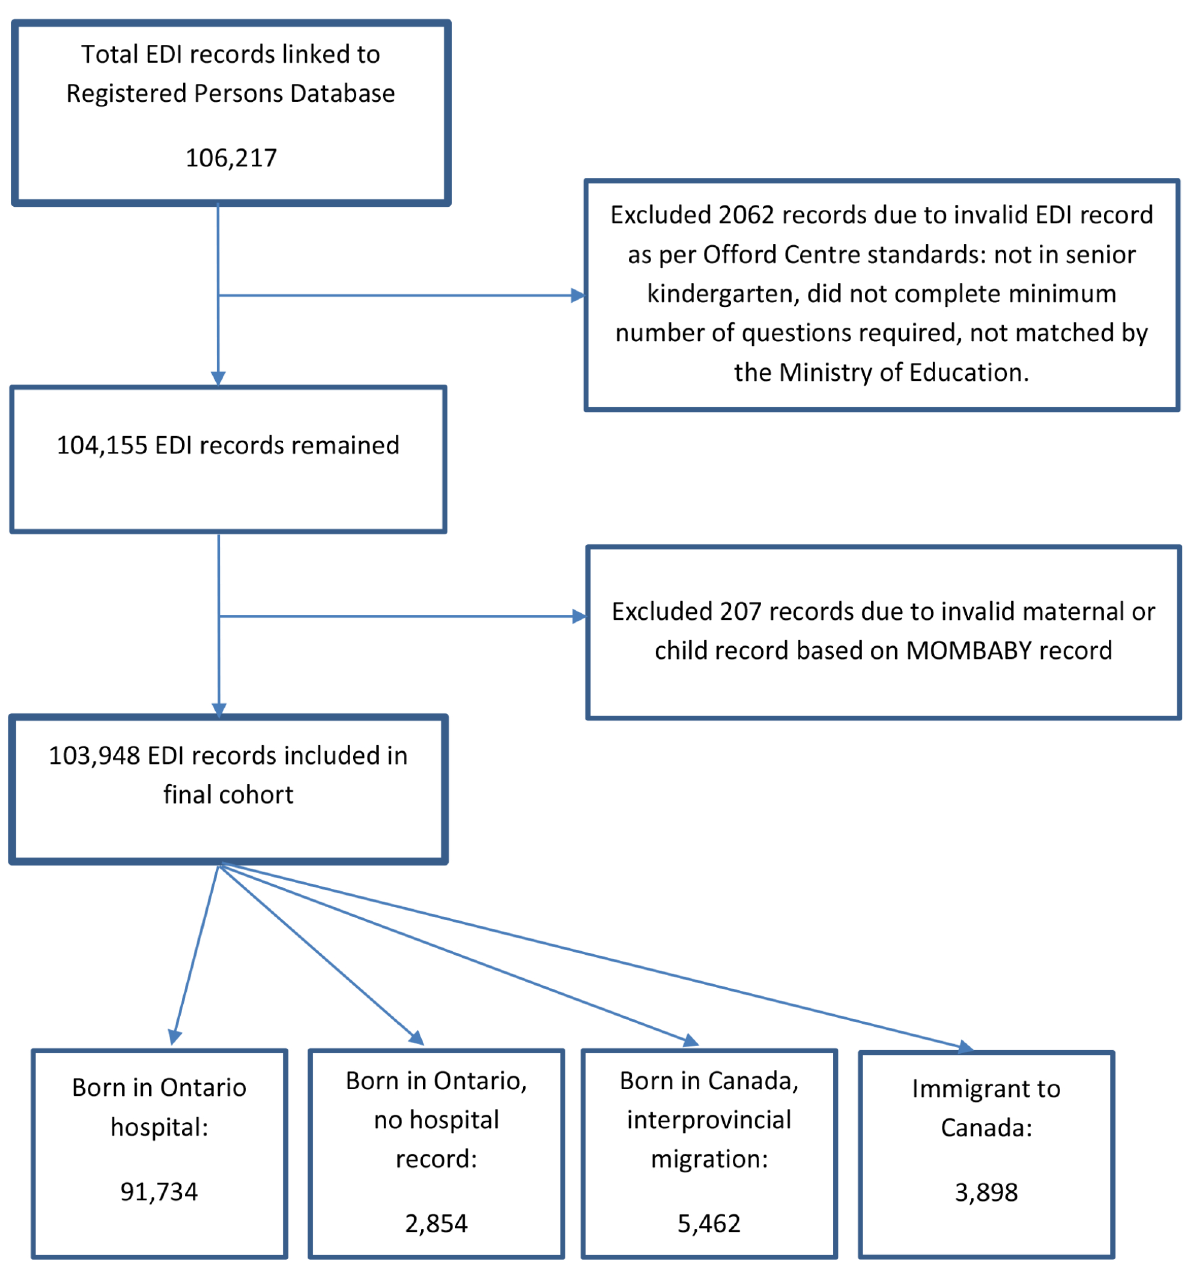
Figure 2: Flow chart of inclusion and exclusions of Early Development Instrument (EDI) records for assessing social and medical risk factors for